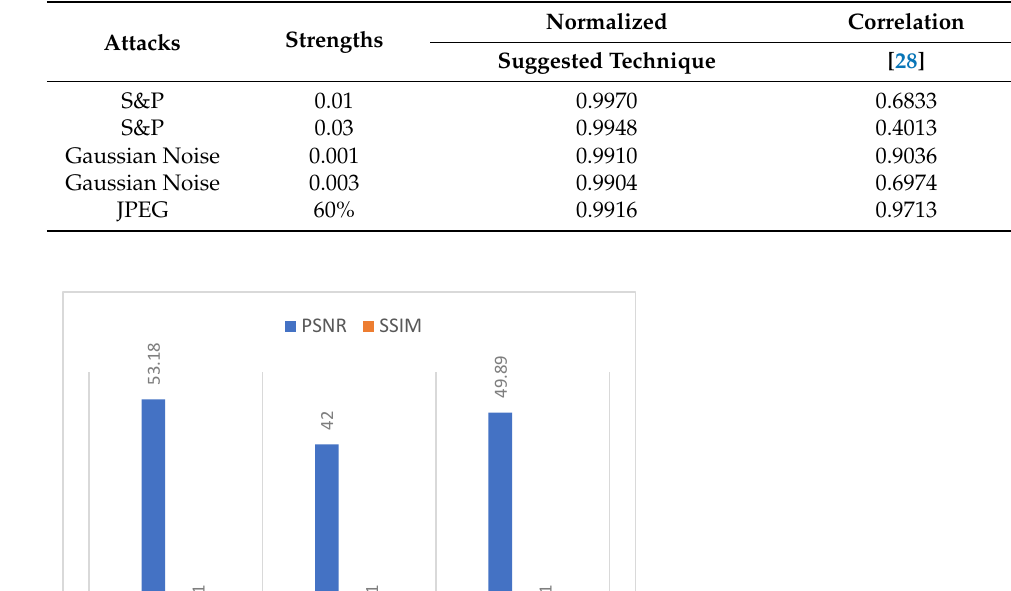
Table 6. Normalized Correlation Against Image Processing Attacks.